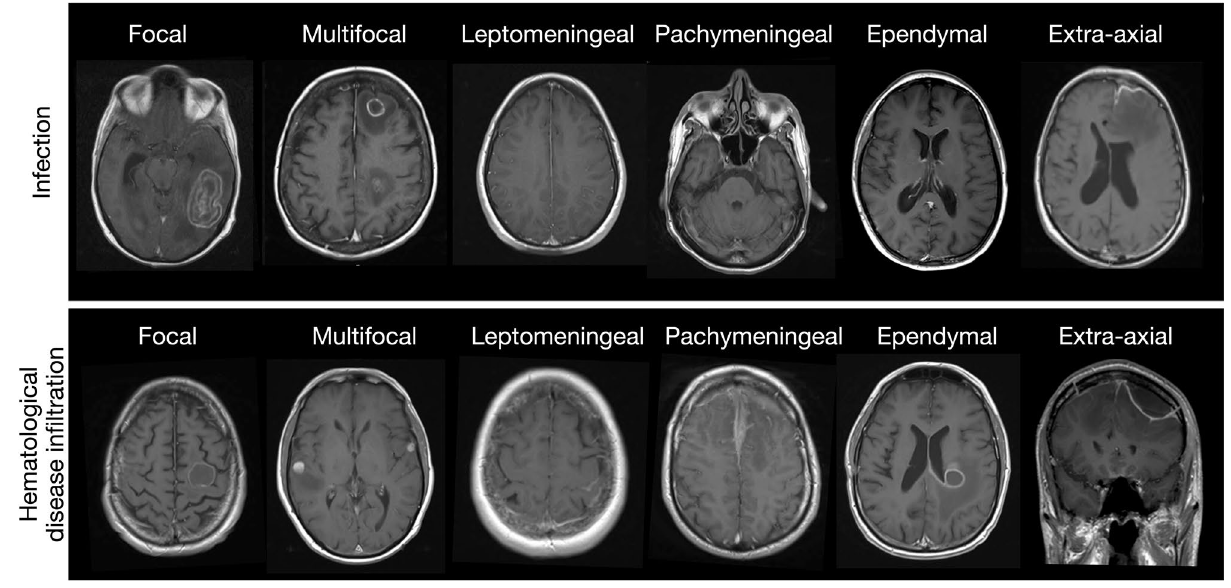
Figure 1. Case examples of anatomical imaging classification in MRI head studies with confirmed final diagnosis of either CNS infection of hematological disease involvement.